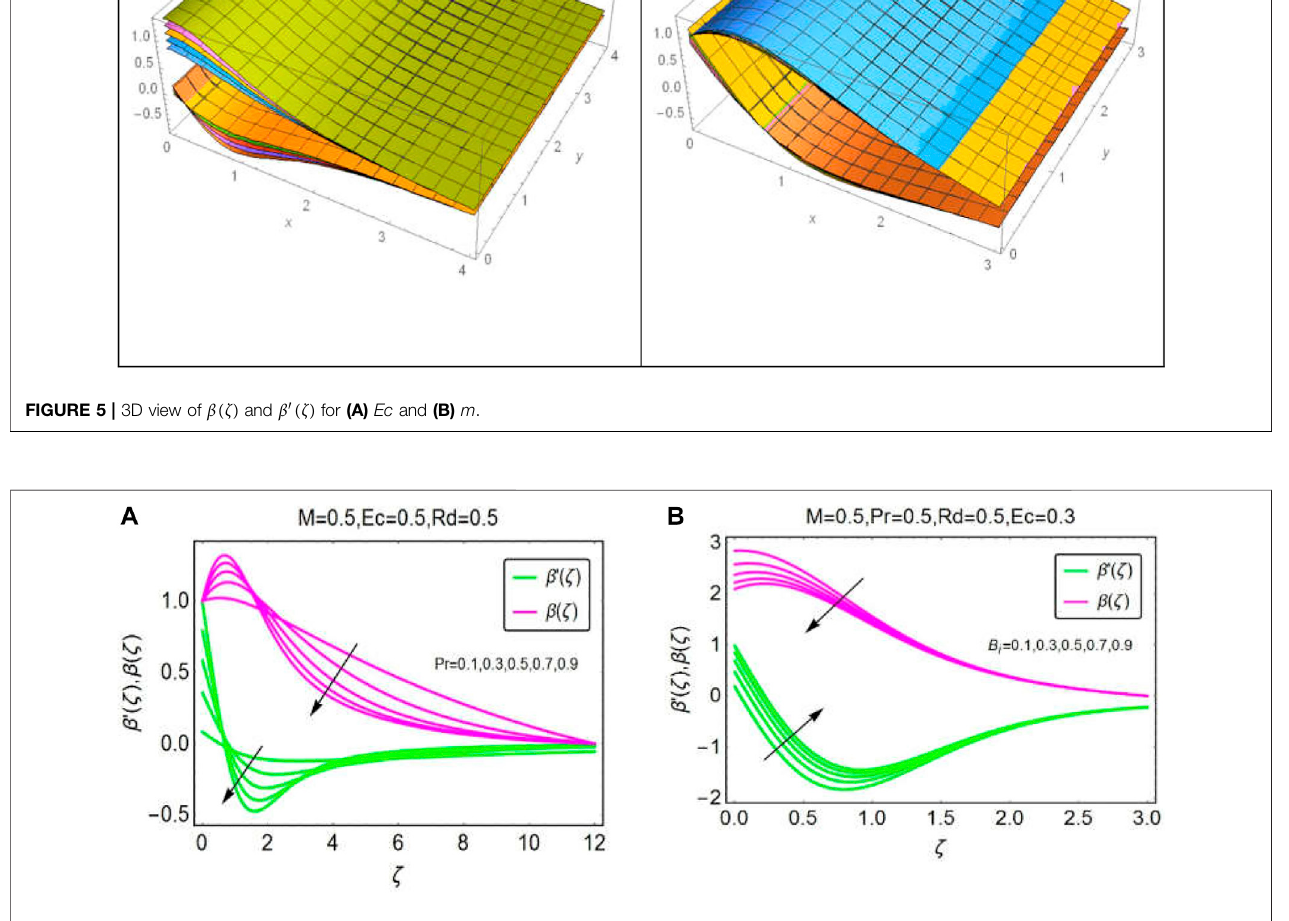
FIGURE 6 | In fl uence of (A) Pr and (B) B i on β ( ζ ) and β ′ ( ζ ) .